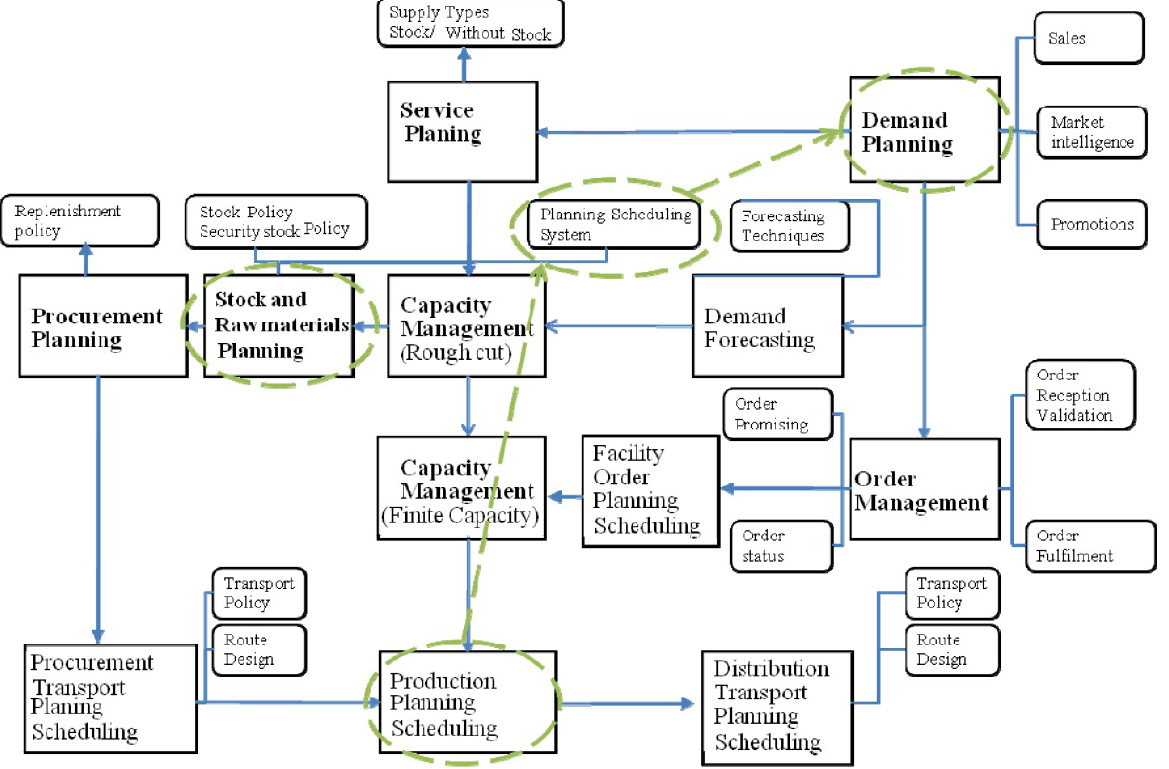
Figure 2. Logistic functions (Errasti,